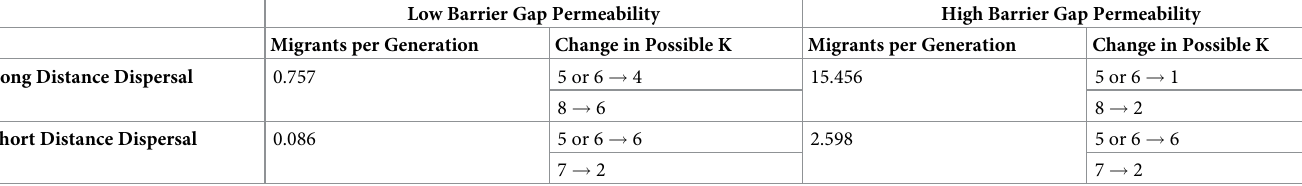
Table 4. The replicated average number of observed migrants per generation, presented as a function of dispersal distance and barrier gap permeability, at the end of the Semi-Connected epoch. In most cases, population genetic structure (change in possible K , evaluated from either the visual interpretation of likelihood probabilities L(K) (top) or from Evanno’s Δ K method E (bottom)) declined from where it began in the prior Isolated Patches